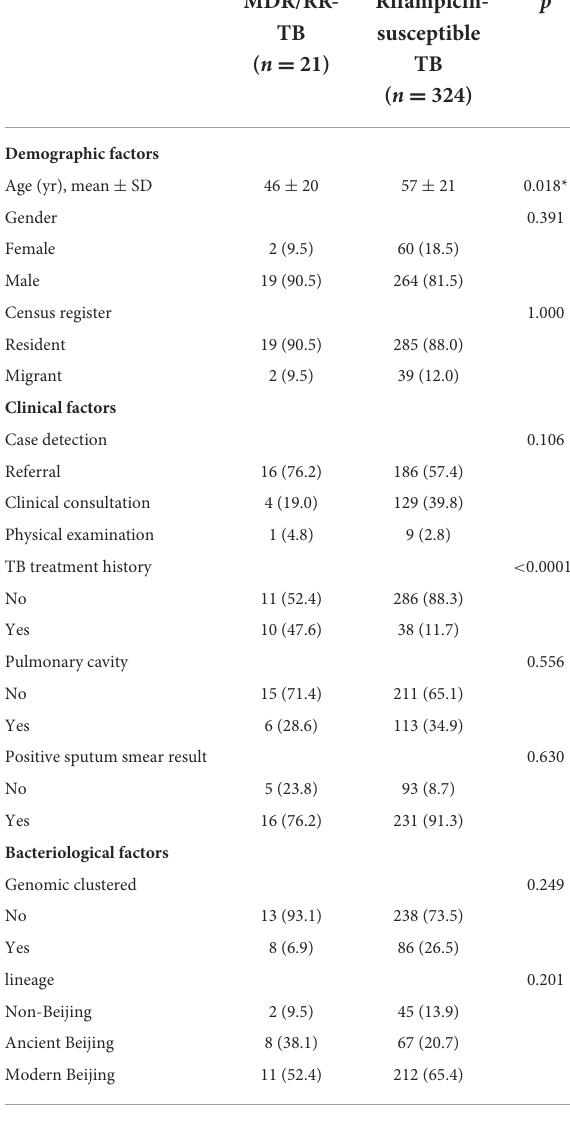
TABLE 1 Characteristics of MDR/RR-TB and rifampicin-susceptible TB patients in Chongming, Shanghai α